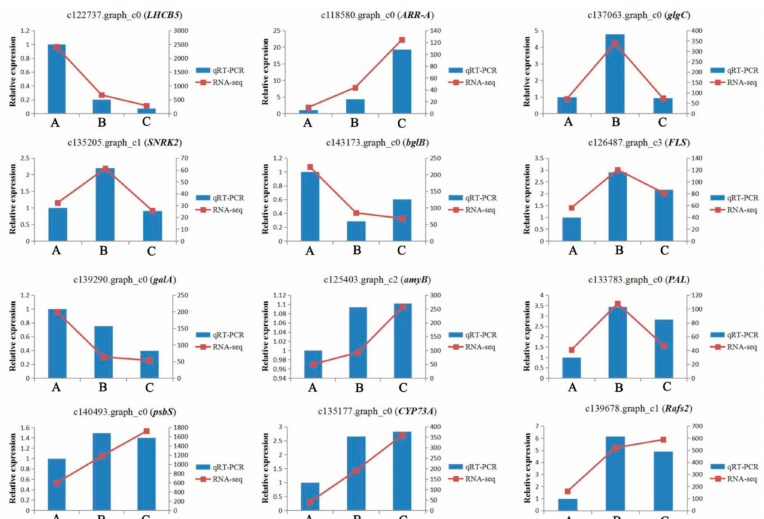
Figure 7. The comparison of the expression levels of 12 DEGs identified related to cold acclimation between RNA-Seq and qRT-PCR analyses from three samples treated at di ff erent